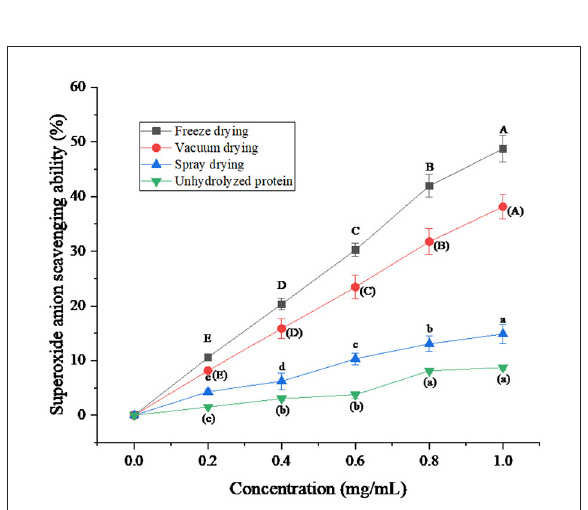
FIGURE7 Hydroxyl radical ( · OH) scavenging ability of protein peptide powder by three dry methods. Different letters express significant differences ( p <